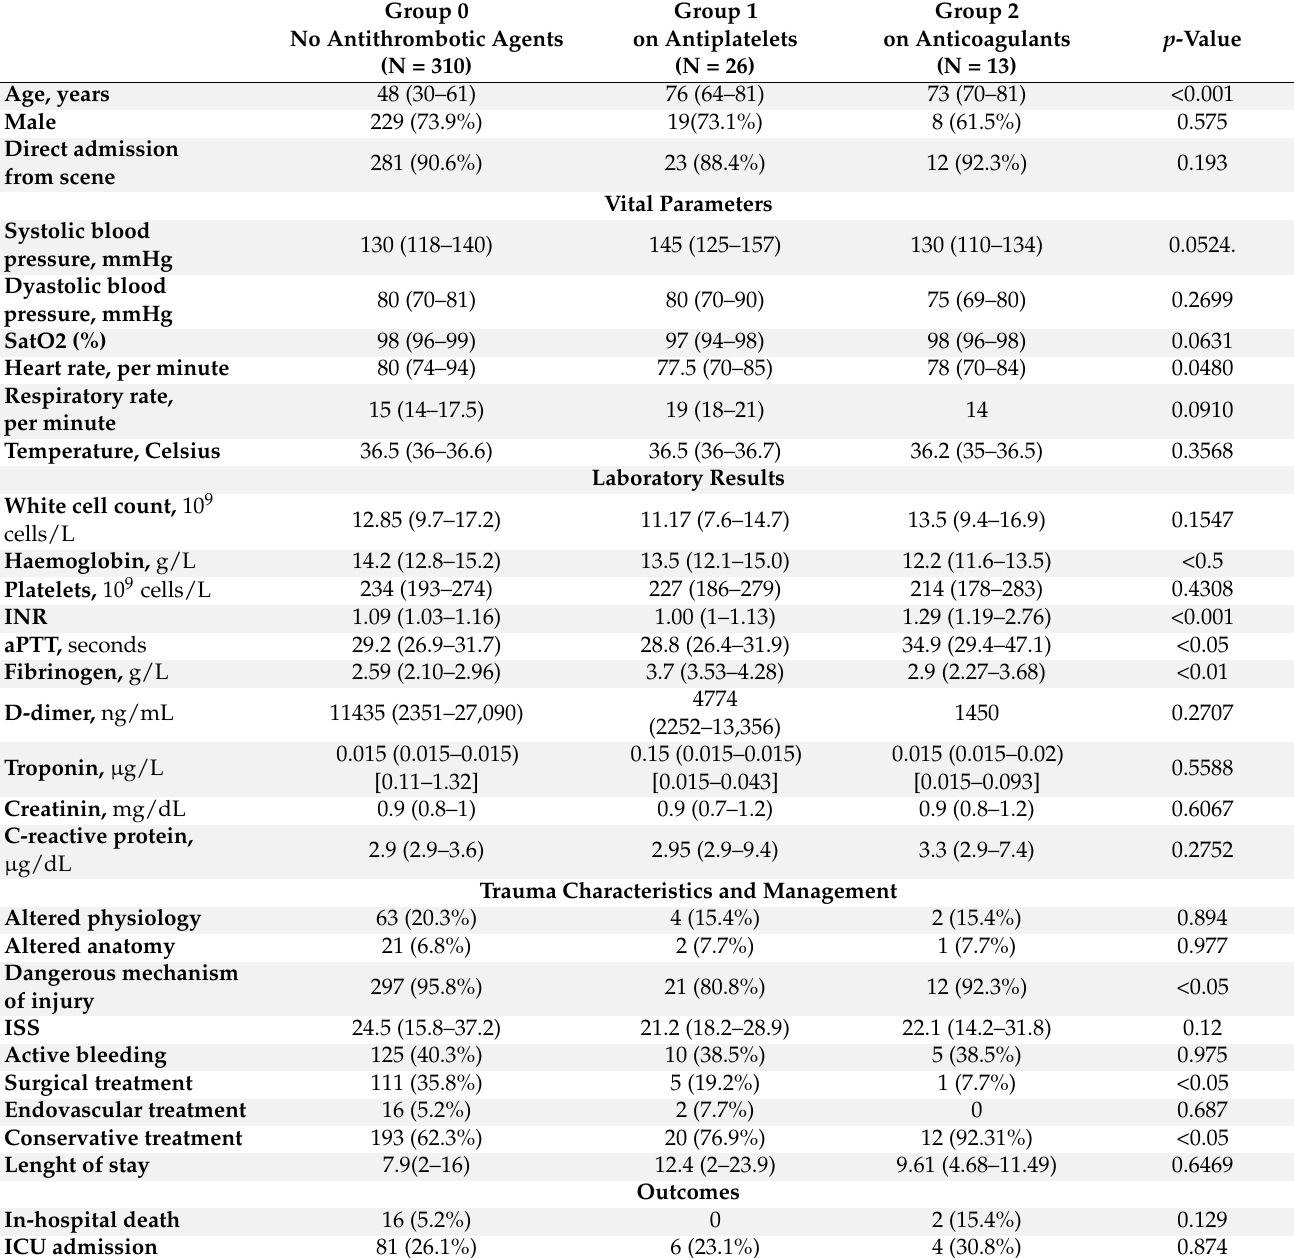
Table 1. Cohort demographics and clinical